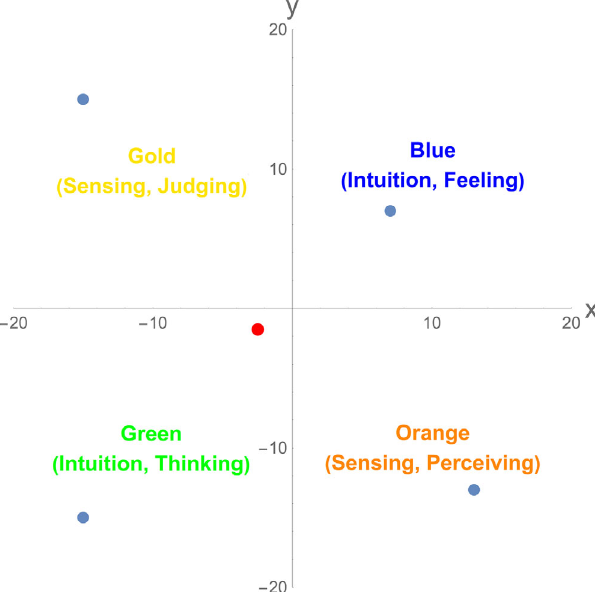
FIG. 1. Illustrating the calculation of the centroid.